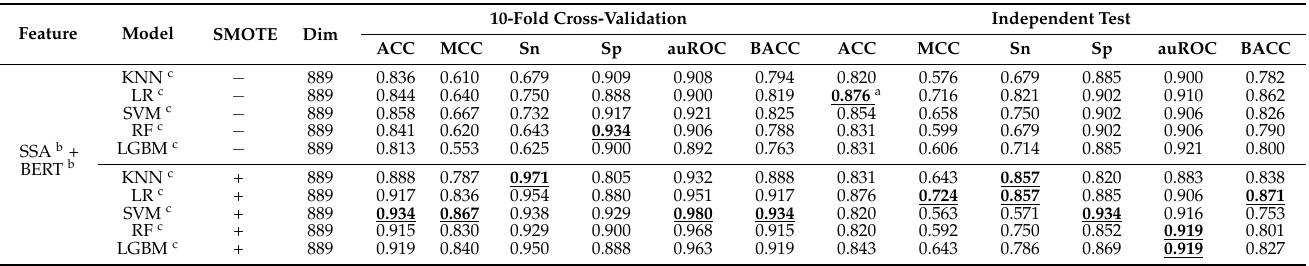
Table 2. Performance metrics of fusion features using five machine learning models with or with- out